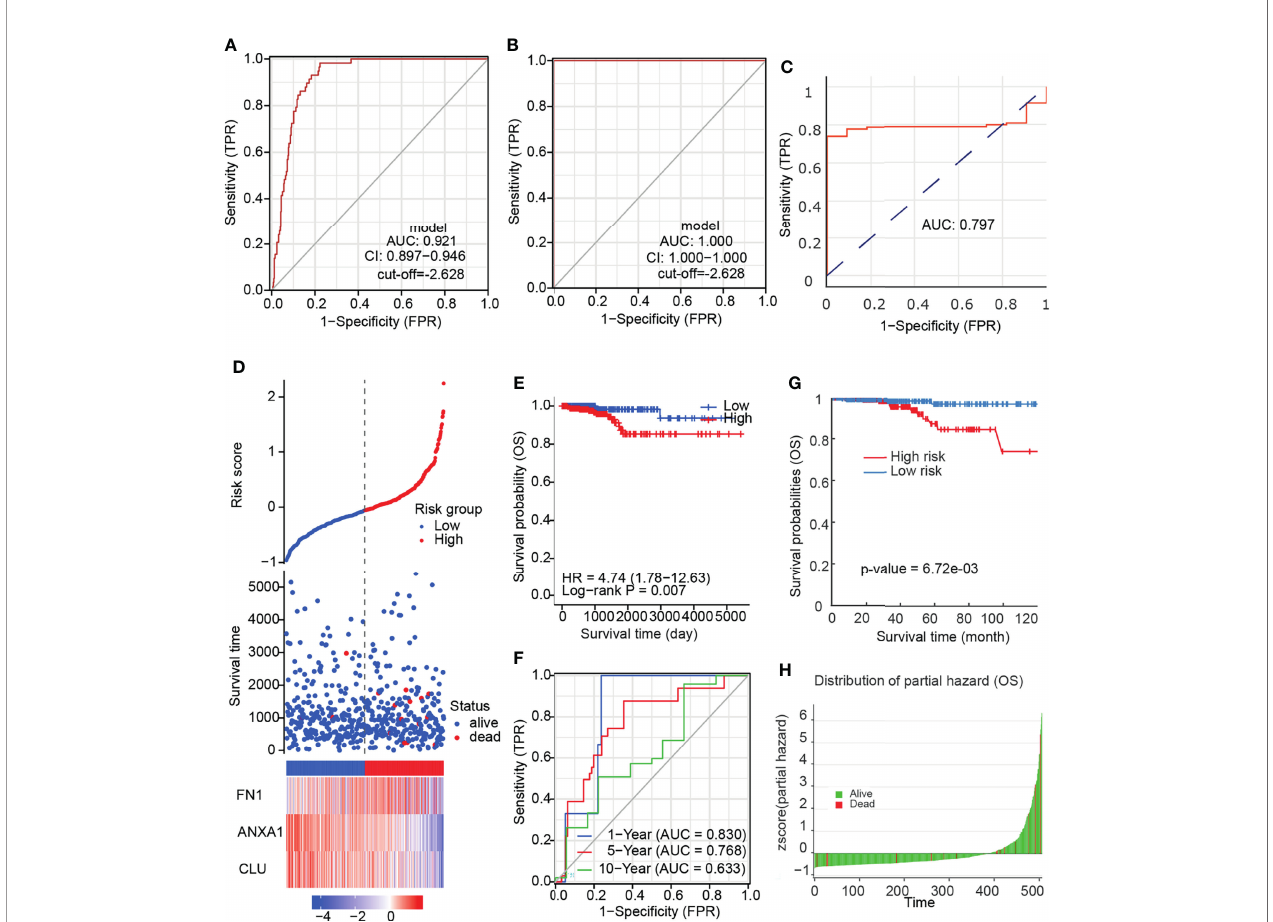
FIGURE 6 | The diagnosis and prognostic model of PTC. (A) ROC curve of diagnostic model based on mRNA expression. (B) ROC curve of diagnostic model validation set based on mRNA expression. (C) ROC curve of diagnostic model based on DNA methylation. (D) Risk factor association diagram based on mRNA expression. (E) KM plot of prognostic model based on mRNA expression. (F) ROC curve predicted by prognostic model for different follow-up time. (G) KM plot of prognostic model based on DNA methylation. (H) Z-score distribution of the prognostic model and survival